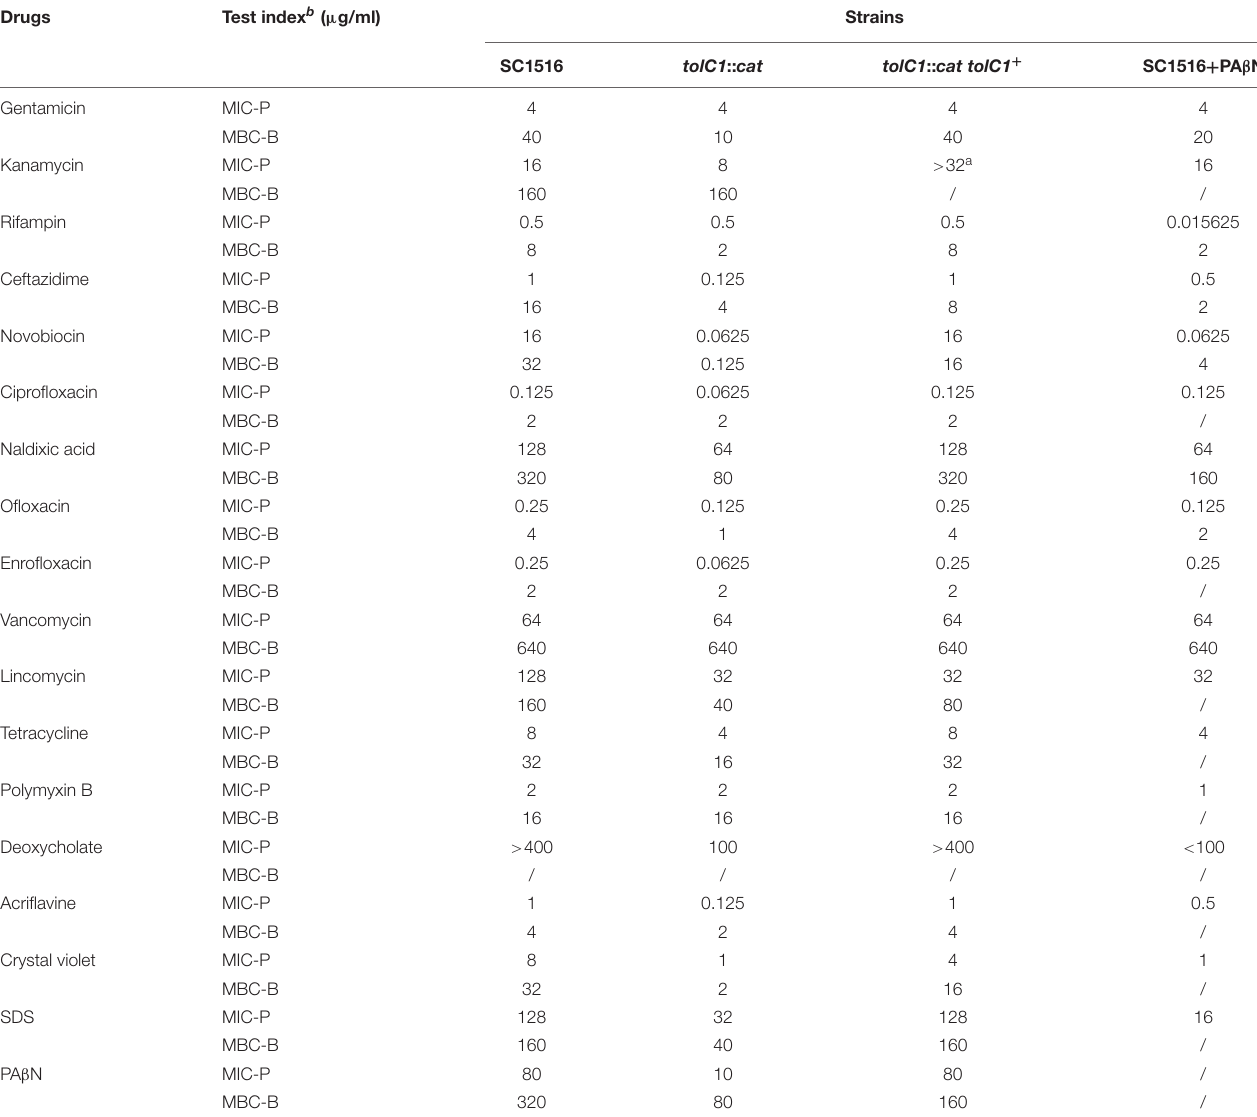
TABLE 3 | Susceptibility of A. pleuropneumoniae strains to different